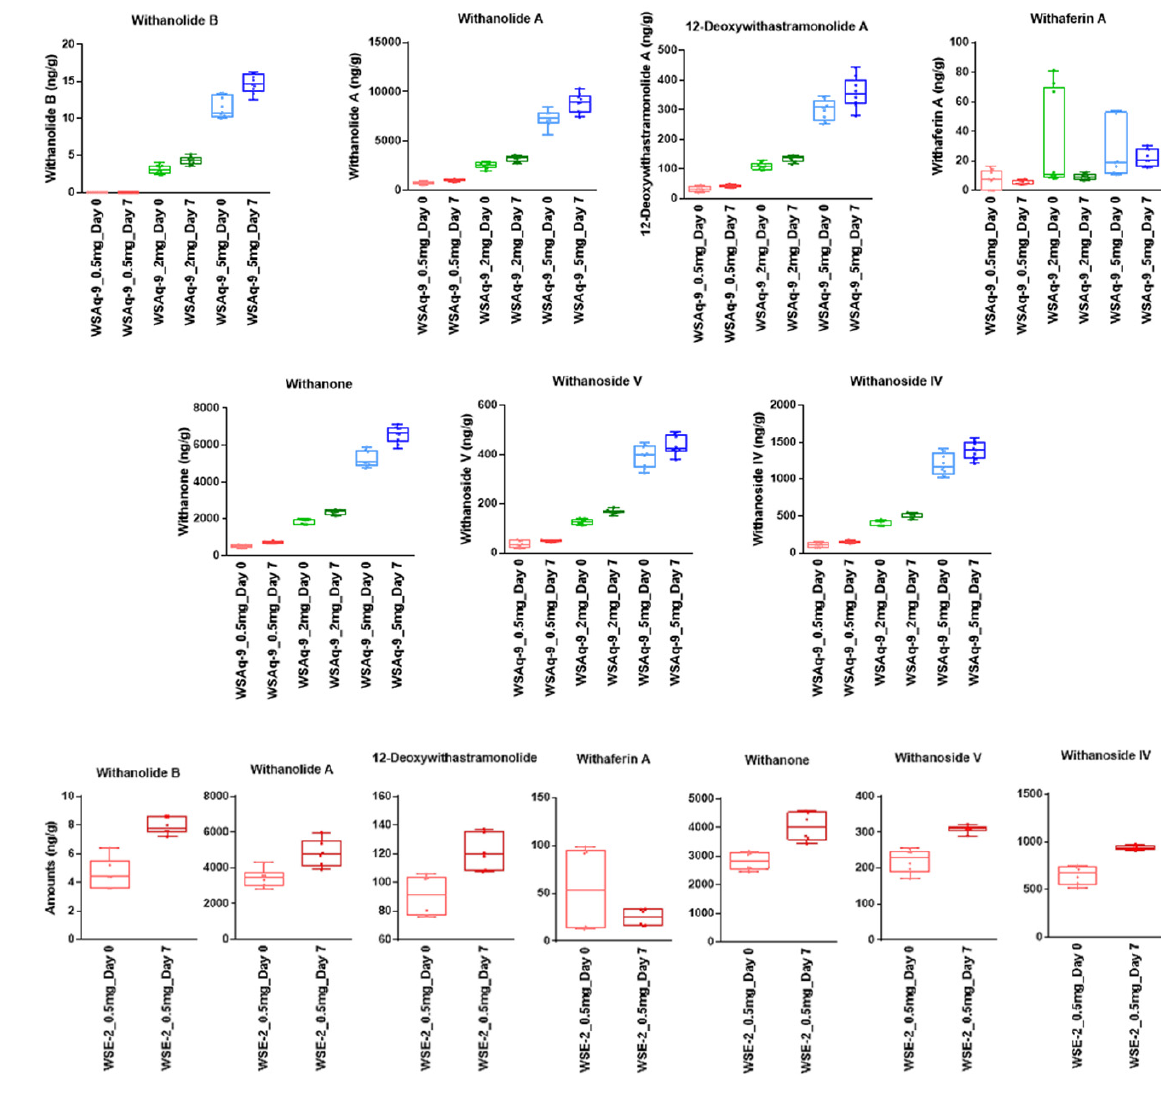
Figure 1. Stability of phytochemical markers in Drosophila food kept for seven days at 25 ◦ C. ( A ) WS phytochemical marker levels (ng/g of food) measured for day 0 (light color) after 7 days (dark color) in food containing 0.5 (red), 2 (green), or 5 (blue) mg WSAq-9 extract/g of food. ( B ) WS phytochemical marker levels (ng/g food) measured for day 0 (light) and after 7 days (dark) in food containing 0.5 mg WSE-2 extract/g food. For WSAq-9, n = 3 with triplicate runs. For WSE-2, n = 2 with triplicate runs. The horizontal bars in the box plots represent the medians, boxes the 25% and 75% quartiles, and whiskers the max. and min.